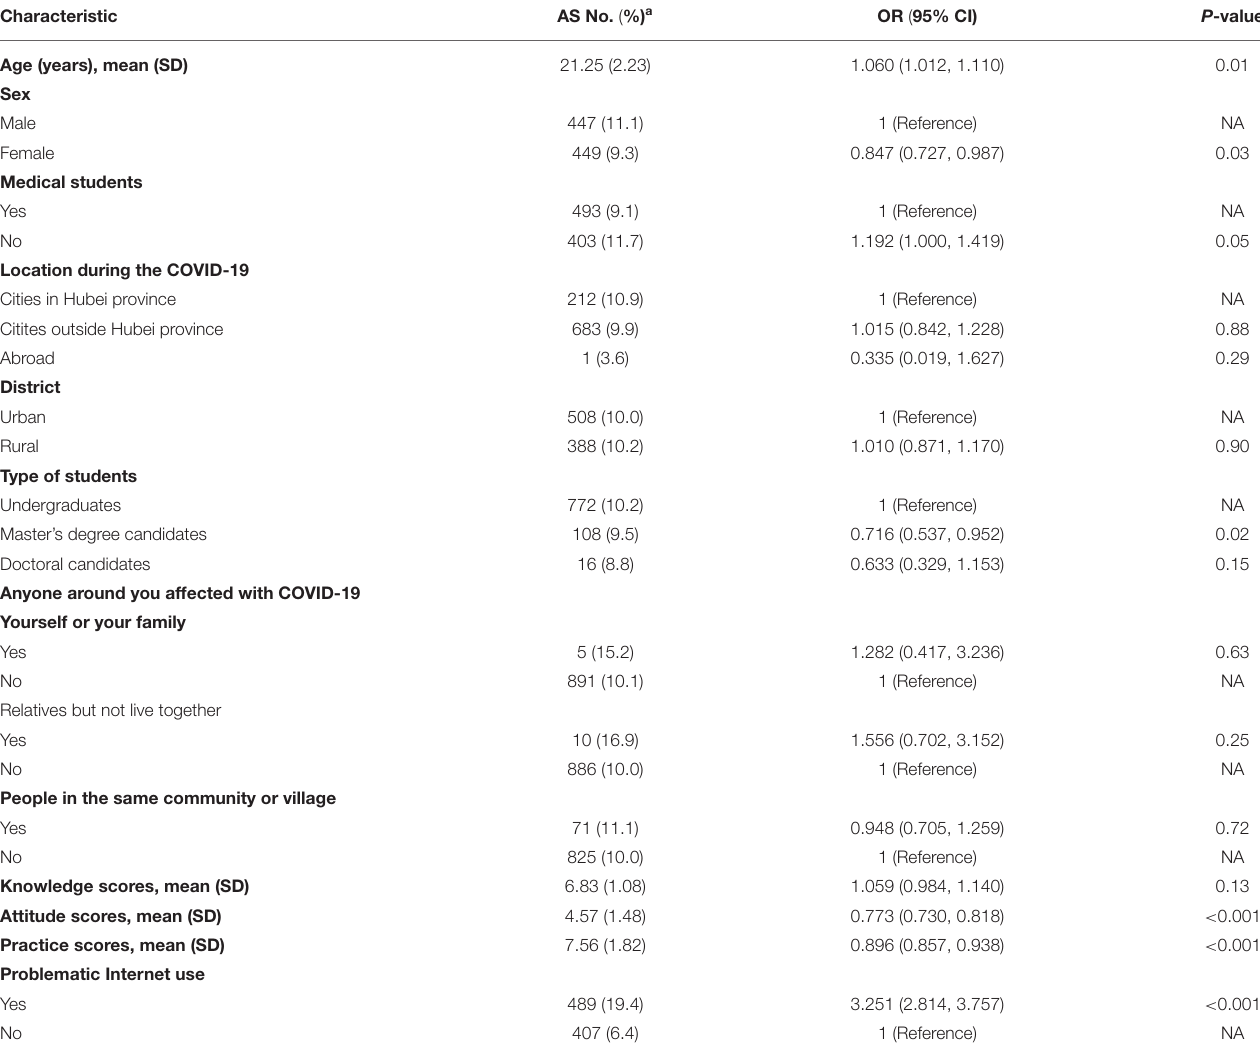
TABLE 4 | Characteristics of participants according to the anxiety symptoms.